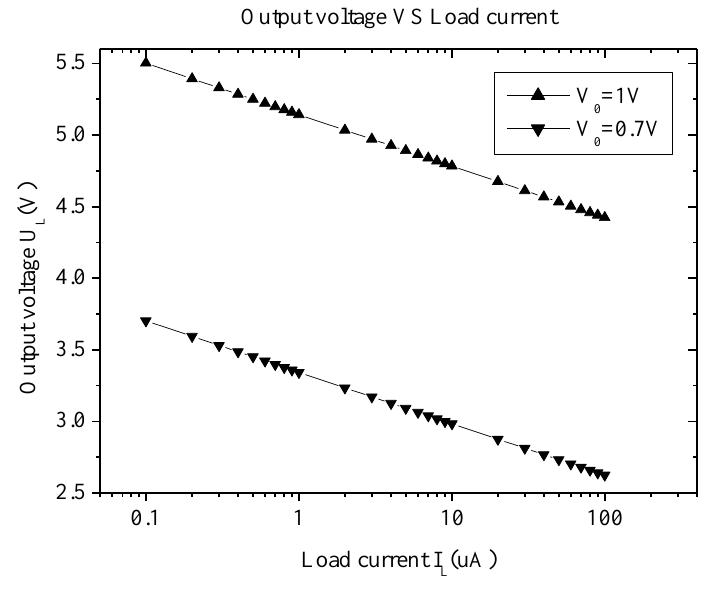
Figure 4. Output voltage of charge pump rectifier with different load